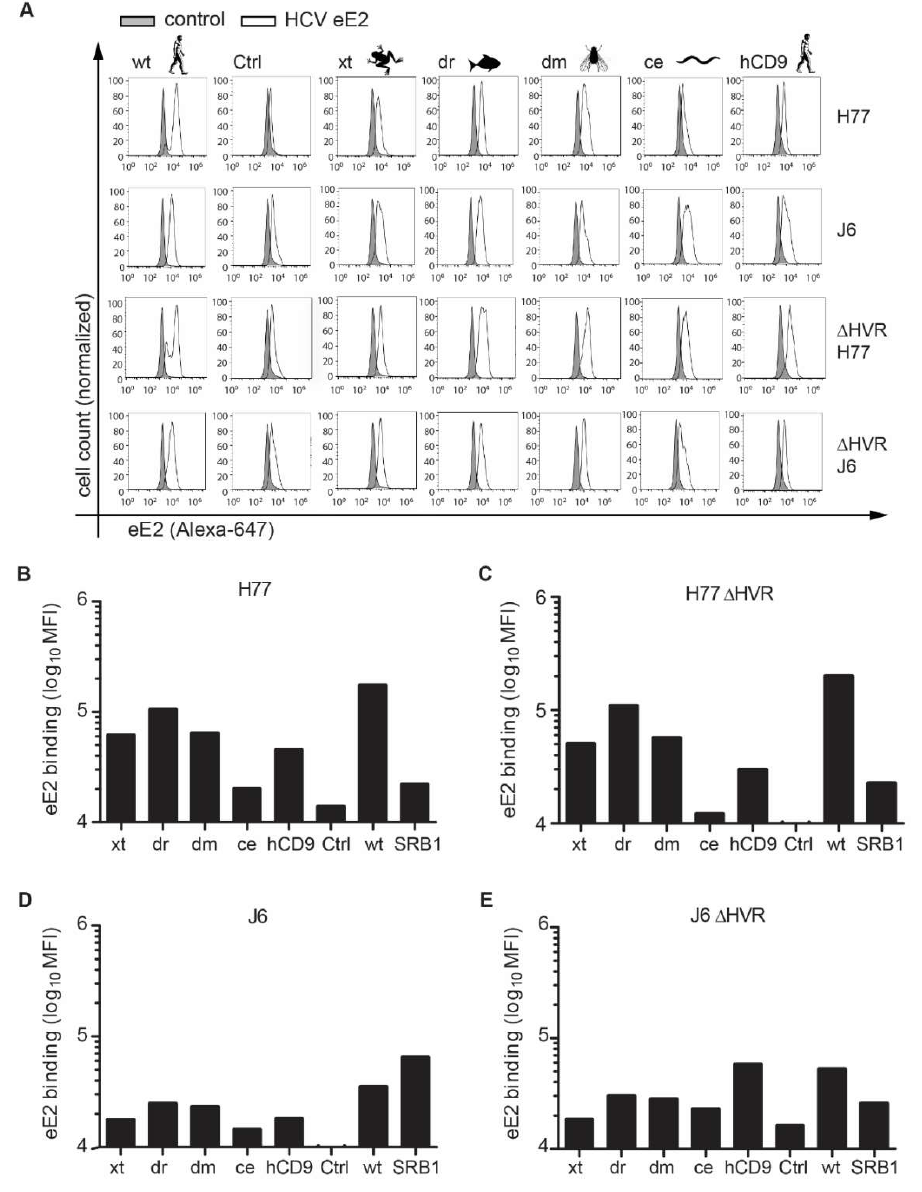
Figure 2. HCV E2 differentially binds to CHO745 cells expressing hCD81 backbone chimeras. ( A ) Binding of Alexa-647 labeled soluble E2 ectodomains (eE2) of the HCV genotypes 1a (strain H77) and 2a (strain J6) with and without the hypervariable region (HVR) to CHO745 cells expressing the indicated hCD81 chimera, full-length protein (wt) or empty vector control (Ctrl). Each histogram shows fluorescence intensities of untreated cells (grey) and cells after Alexa-647 eE2 binding (white); ( B – E ) Quantitation of eE2 binding to CHO745 cells expressed as MFI of Alexa-647. CHO745 cell expressing SR-BI served as additional positive control. Data show one representative experiment of three independent biological replicates.